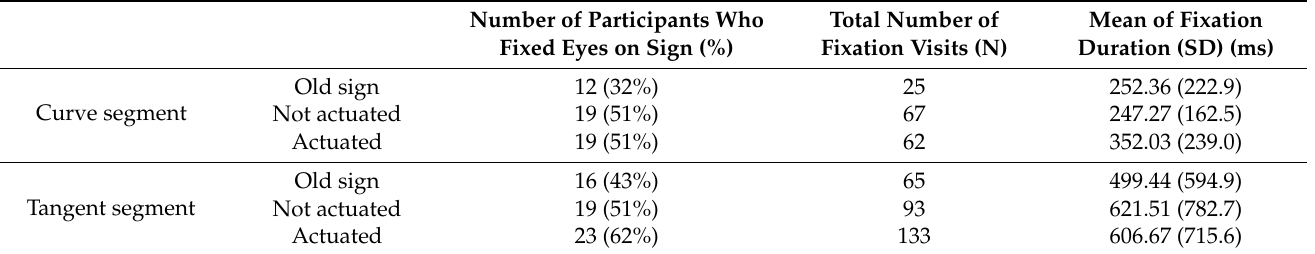
Table 4. Fixation visits and fixation duration for each sign in two